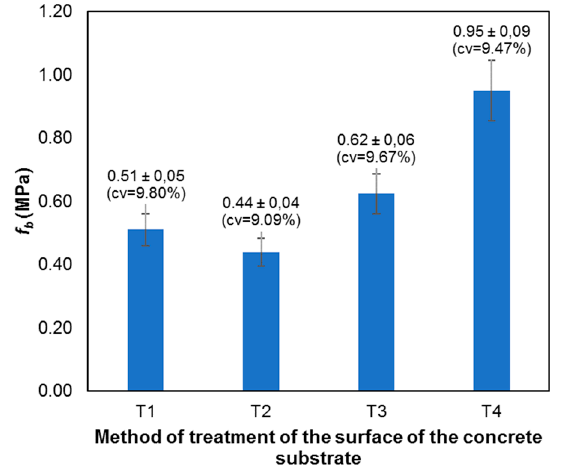
Figure 9. Division of concrete treatment methods (based on Reference [5]).